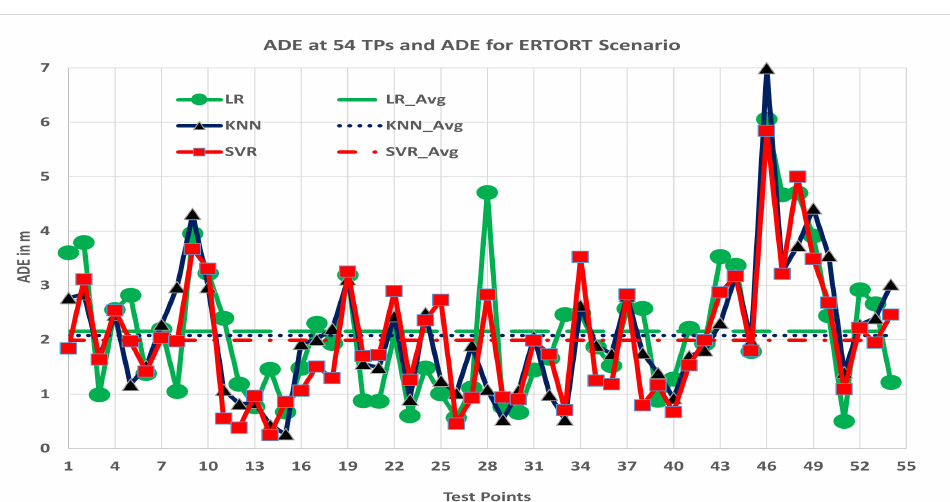
Figure 10. ADE at 54 TPs and ADE for ERTORT